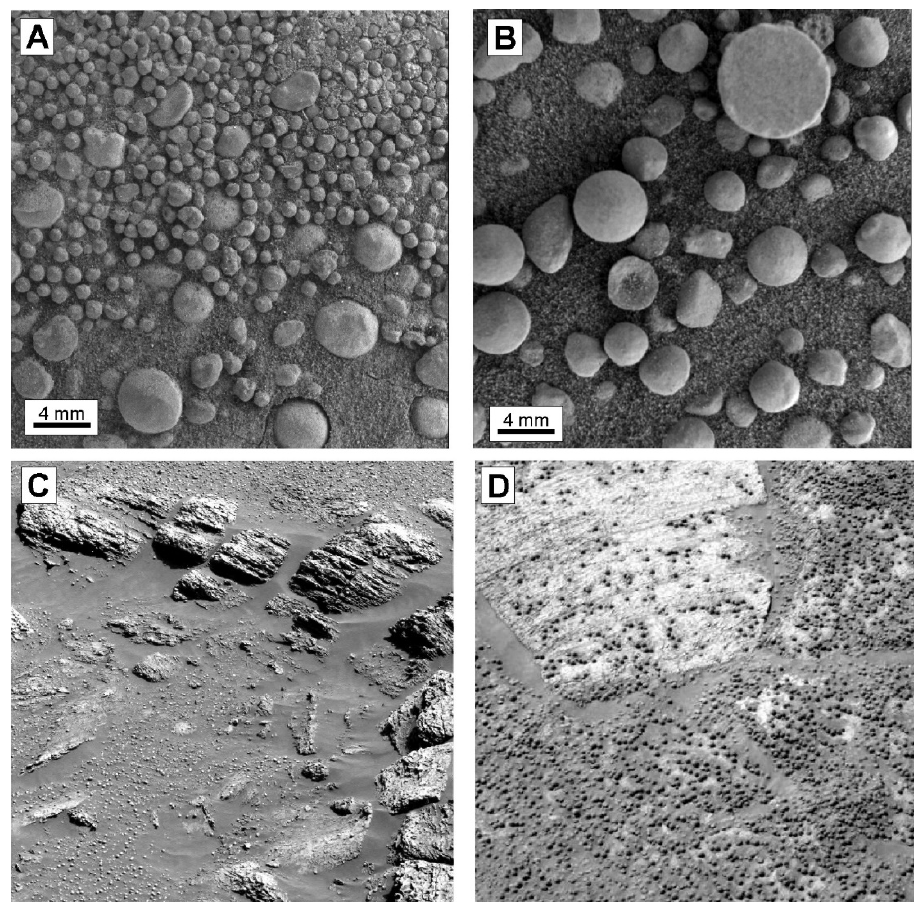
Figure 1. Martian iron spherules recovered in soil deposits and aeolian dunes from the Red Planet. ( A , B ) Haematite spherules in the iron-rich soil of Meridiani Planum acquired by the Microscopic Imager on NASA's Mars Opportunity rover (sol 924-1m135641102iff1300p2956m2f1_0PCT near Victoria Crater and sol 84-1m210211964iff758zp2957m2f1_0PCT beside Fram Crater, which Opportunity passed on its way from Eagle Crater, respectively). ( C ) Sedimentary, thickly laminated, evenly stratified rock type, containing haematite spherules, which forms stratigraphically beneath cross-bedded sandstones interpreted as ancient river deposits. This panoramic image was taken by NASA’s Opportunity rover on Sol 14 Pancam images of the northeast end of the Eagle crater, at Meridiani Planum. ( D ) Layered sedimentary rocks containing haematite spherules which are also scattered on soils. This panoramic image was taken by NASA’s Opportunity rover on Sol 109 Pancam images of the rim of Endurance Crater at the Meridiani